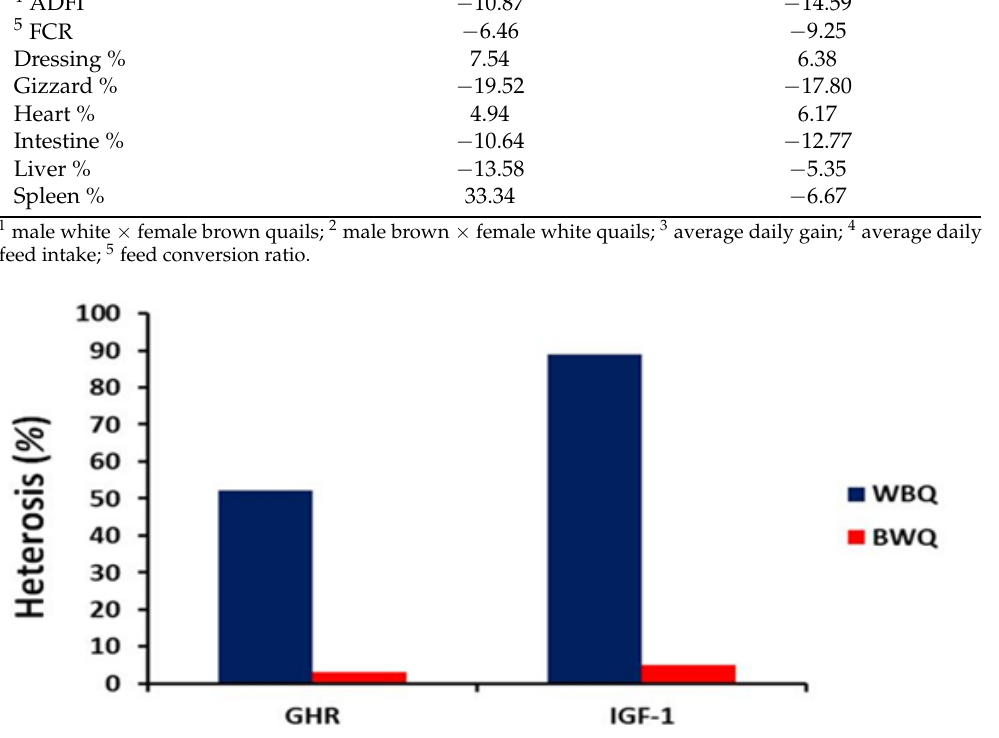
Figure 2. Heterosis percentages of relative expression of growth hormone receptor (GHR) and in- sulin-like growth factor-1 (IGF-1) genes. WBQ: male white × female brown quails; BWQ: male brown × female white quails.